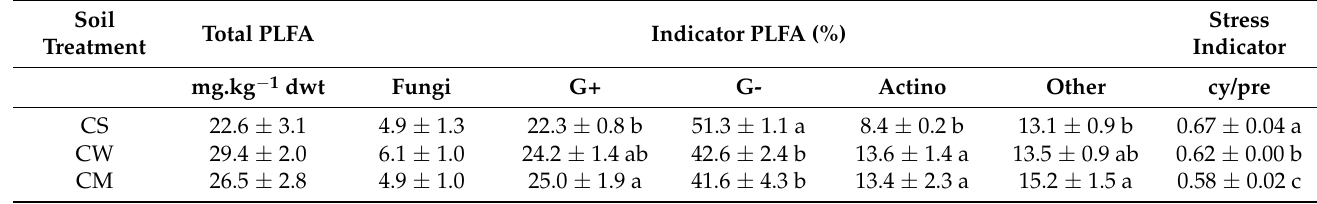
Table 2. Total PLFA concentrations (mg.kg − 1 ), microbial community structure (%) based on indicator fatty acids and the cy/pre stress indicator in unplanted soil (CS), soil cultivated by wheat (CW) and soil cultivated by miscanthus (CM) at 0–10 cm depths. Values are presented as means ± SD. Different letters refer to significant differences in soils (Fisher LSD test, n = 4, p ≤ 0.05).